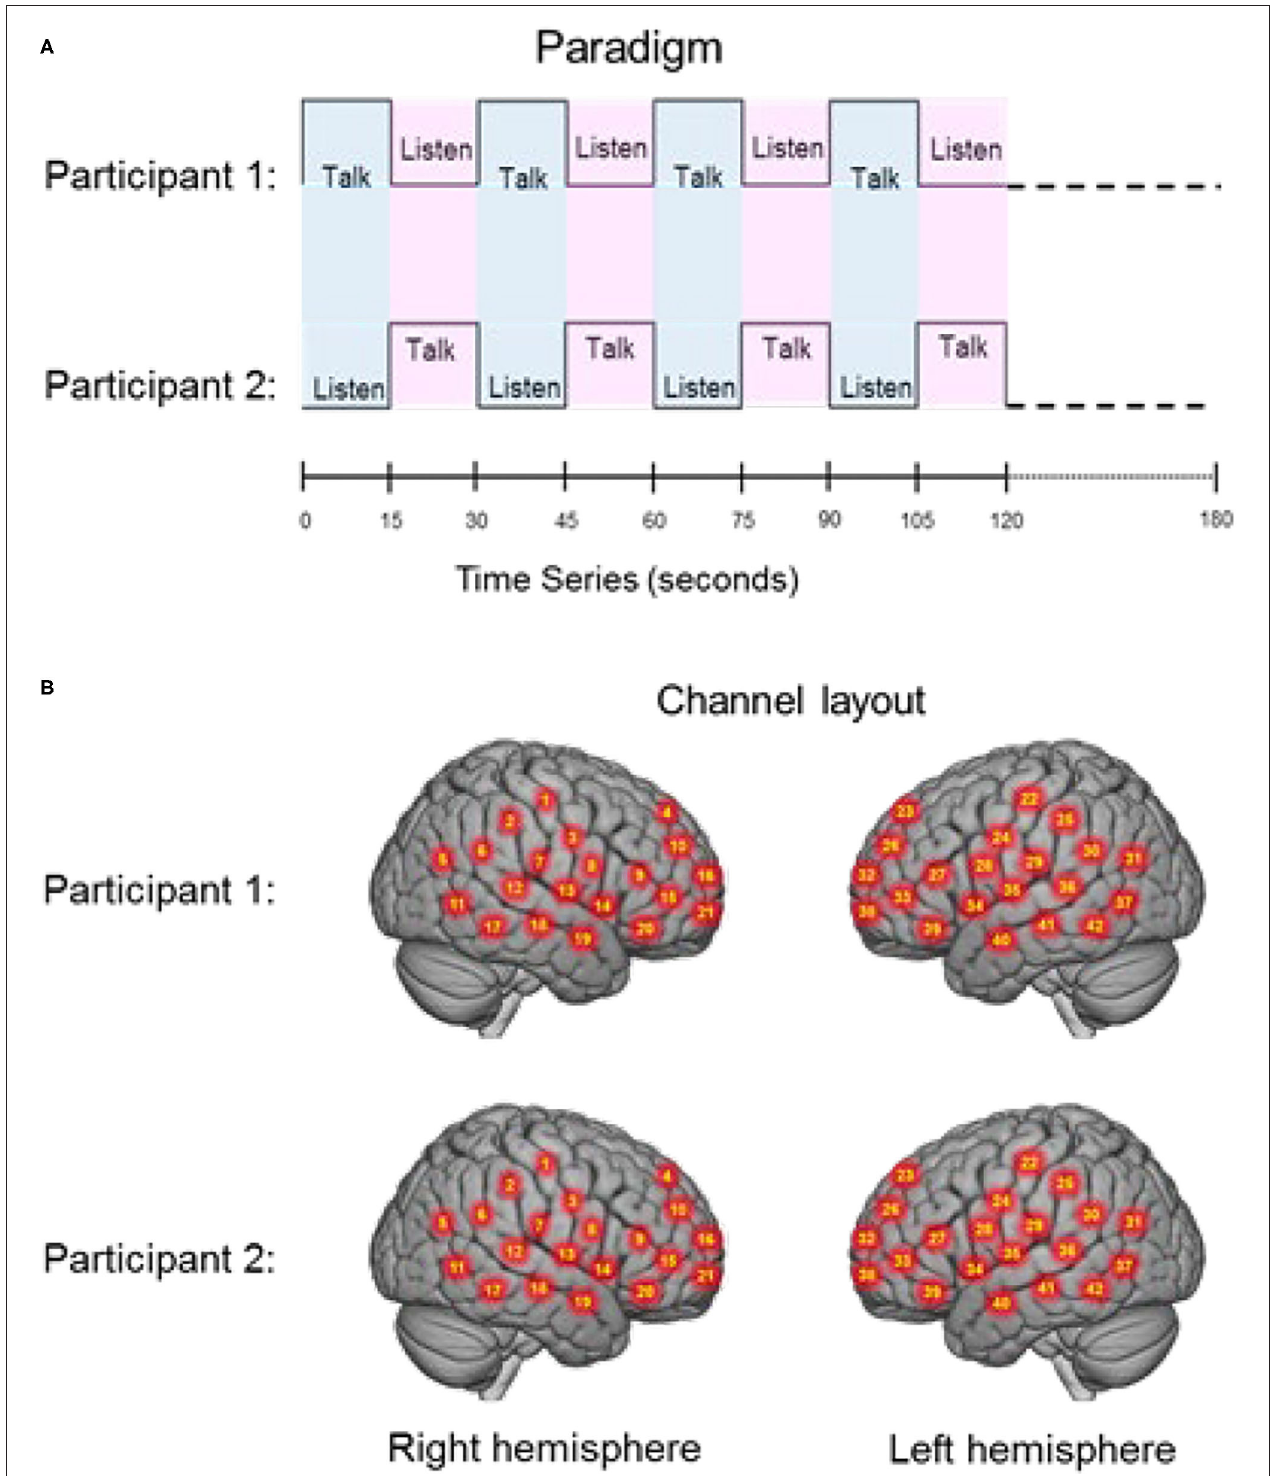
FIGURE 1 | (A) Experimental paradigm. Participants alternated between talking and listening to each other every 15s of each 180s run (see Hirsch et al., 2018); (B) Right and left hemispheres of rendered brains illustrate average locations (red circles) for the 42 channels per participant identified by number. Montreal Neurological Institute (MNI) coordinates were determined by digitizing the locations of the optodes in relation to the 10–20 system based on conventional landmarks. See Supplementary Table 1 for group median coordinates, anatomical regions, and atlas-based probabilities for each channel.